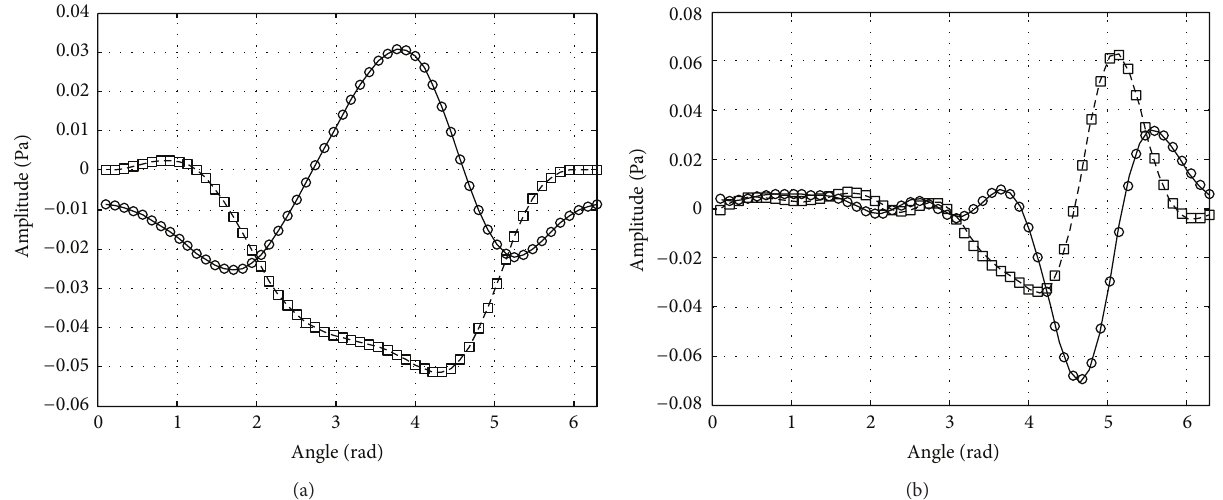
Figure8:Hydrodynamicpressuresalongthecommoninterfaceofthe8thinclusionfor(a) 𝜔 = 400 Hzand(b) 𝜔 = 1000 Hz(—,real-iterative; ----, Imag-iterative; I , Real-direct; ◻ ,